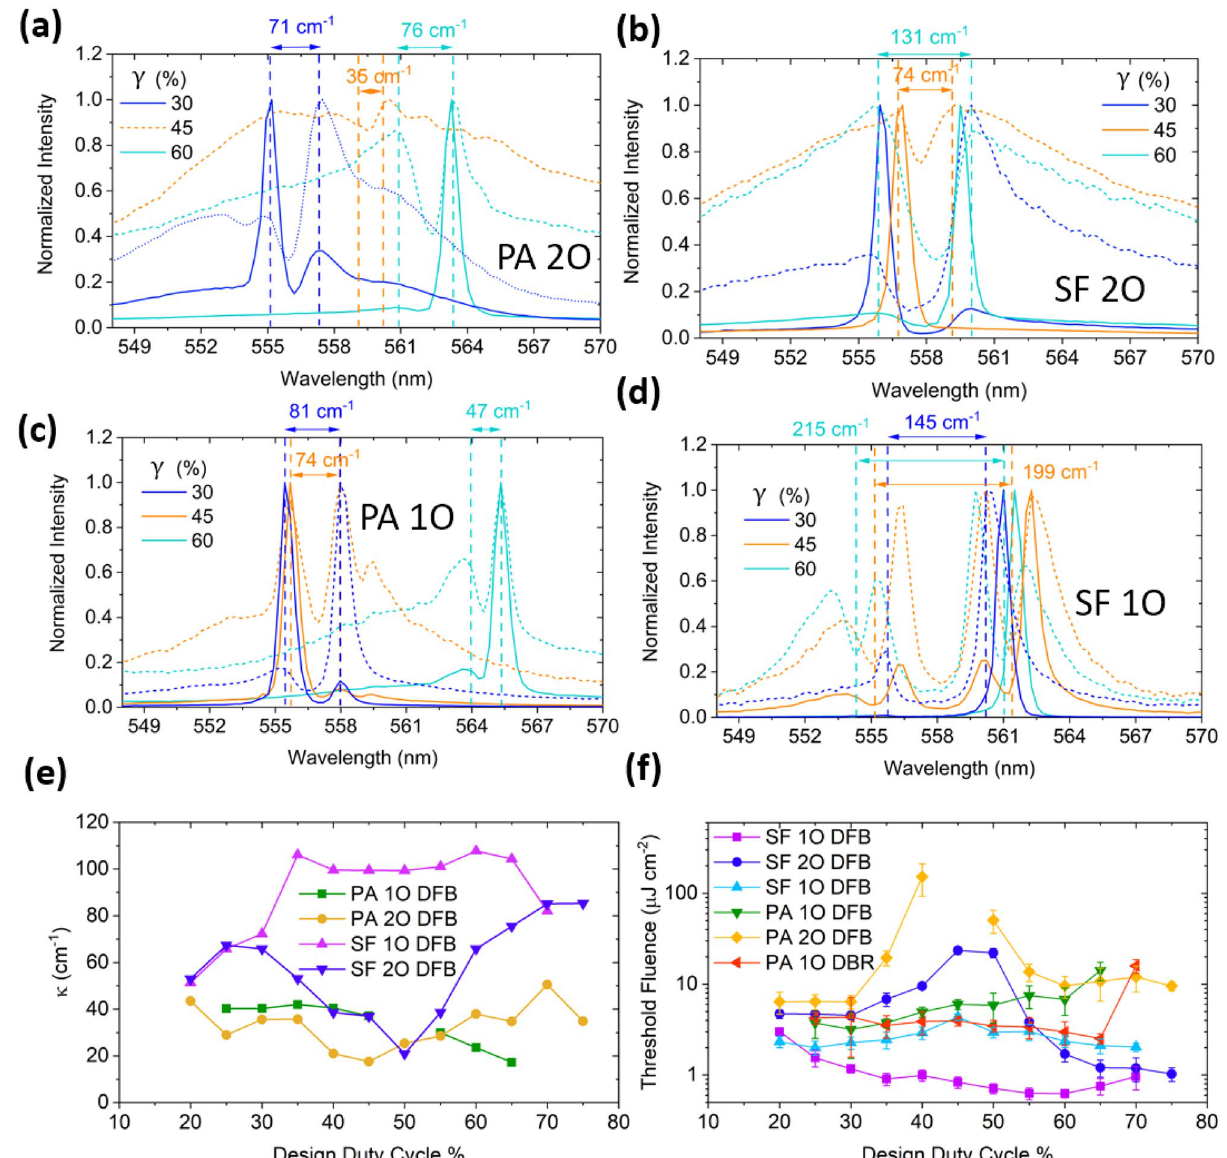
Figure 4. Spectra for above lasing threshold (solid line) and below lasing threshold (dashed line) with stopband widths for 30, 45, 60% γ of ( a ) PA 2O, ( b ) SF 2O, ( c ) PA 1O, ( d ) SF 1O DFB lasers. ( e ) Calculated coupling coefficients based on measured stopband widths of DFB lasers. ( f ) Threshold fluence dependence on design duty cycle for 1O DBR, 1O DFB and 2O samples for both substrate–film (SF) and PDMS-air (PA) gratings